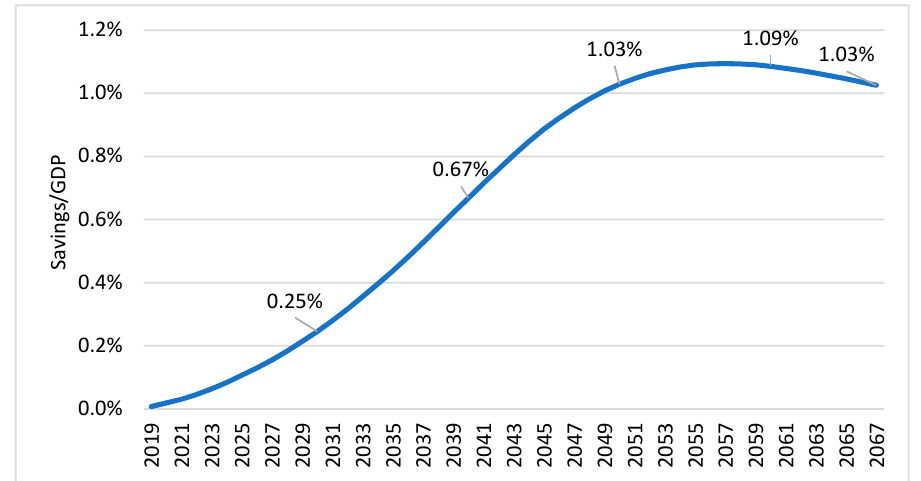
Figure 5. Annual savings/GDP with the application of the SF. Source: Prepared by the authors.